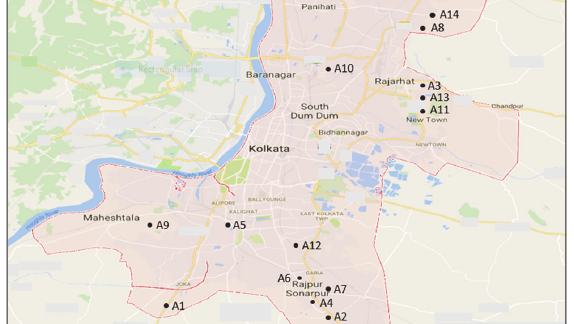
Fig. 1 Locations of 14 under-construction housing projects in